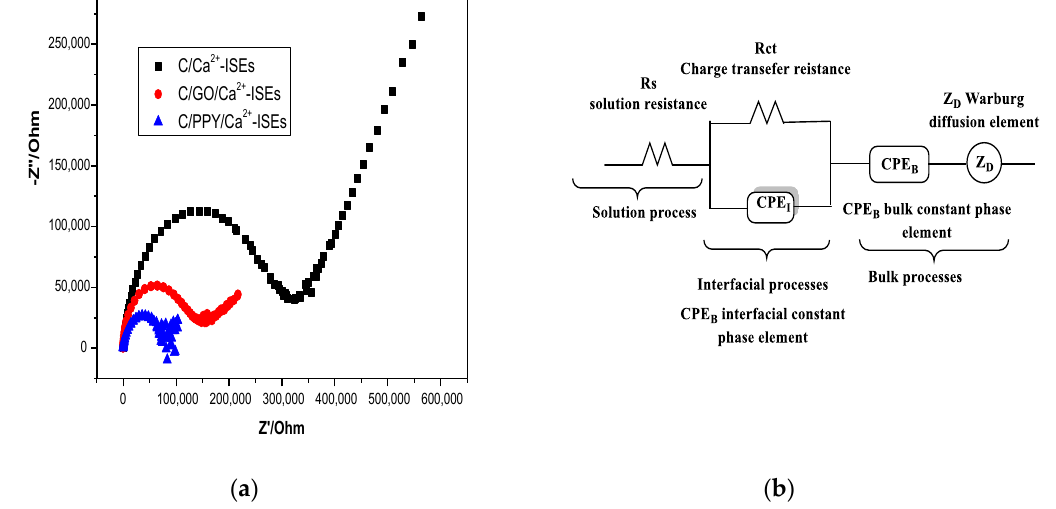
Figure 5. ( a ) Impedance spectra for all solid-state Ca 2+ /ISEs; ( b ) equivalent circuit for the proposed ( a ) Impedance spectra for all solid-state Ca 2 + / ISEs; ( b ) equivalent circuit for the electrodes. proposed